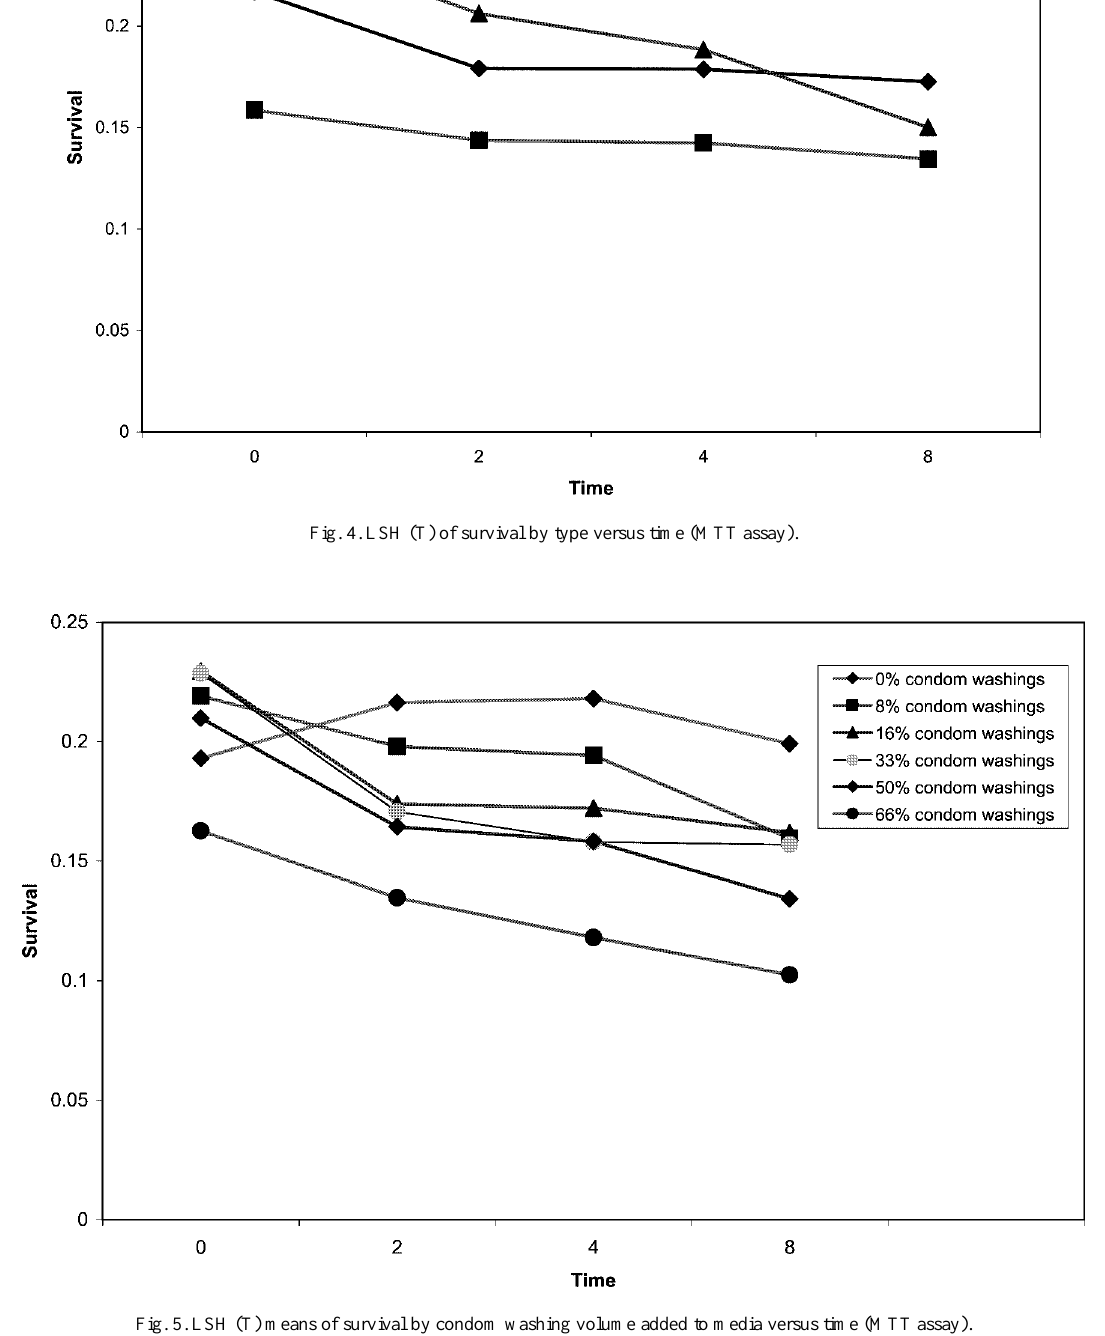
Fig. 5. LSH (T) means of survival by condom washing volume added to media versus time (MTT